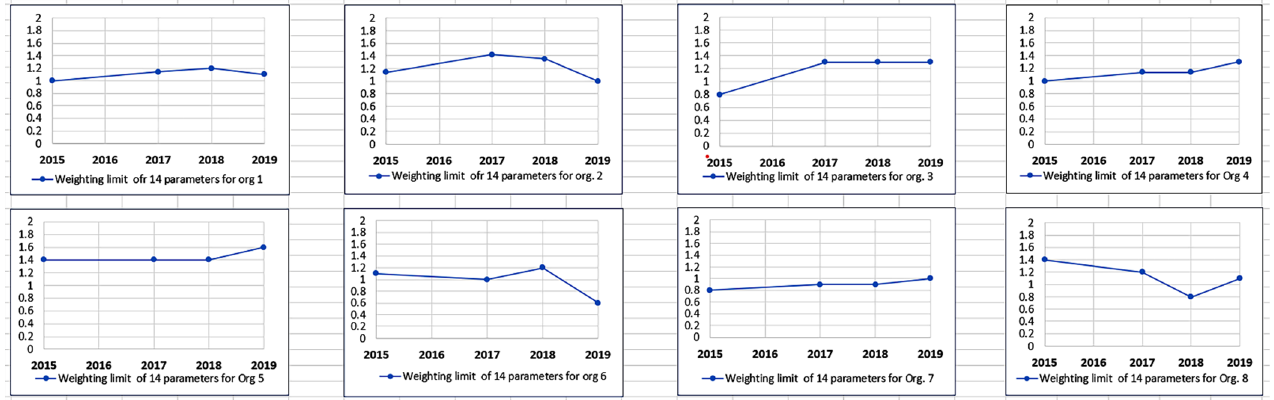
Figure 10. Alteration trend for SI parameters during 2015 and 2017–2019 for Orgs. 1–8. A comparison between the parameters results for the 171 municipalities that partici- pated in the SI survey in 2019 and the results for the eight studied organizations in 2019 are shown in Table 1. The table shows that Orgs 1–8 had a smaller proportion of red results in all parameters compared to the national results of all 171 participants. This is in line with [7], which noted that municipalities with more than 50,000 inhabitants had improved results, especially with a smaller proportion of red parameters than municipalities with fewer than 20,000. However, the proportion of green parameters for Orgs 1–8 was not larger for all parameters, and it was even lower for some of them, especially those that require long-term strategies and planning. The parameters “W and WS planning”, “Cli- mate adaptation and flood security”, and “Status of W and WS fixed facilities” are three examples where none of the eight organization have green status. This is in line with SI